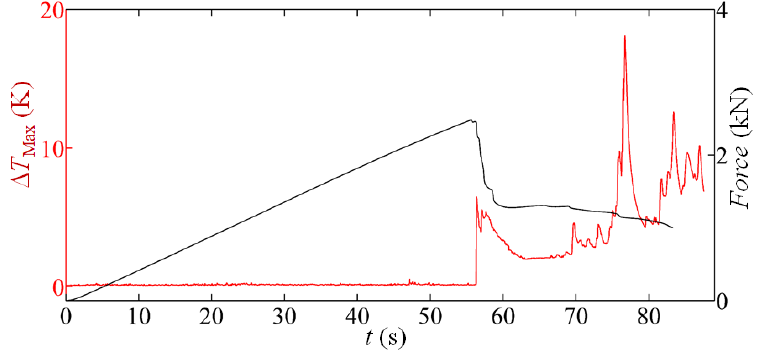
Figure 9. A comparison between force distribution (black) and maximum surface temperature ( ∆ T Max ) distribution (red).